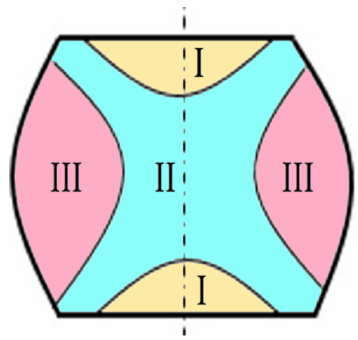
Figure 3. Deformation zones in upsetting (Zone I—minimum deformation; Zone II—maximum deformation; Zone III—medium